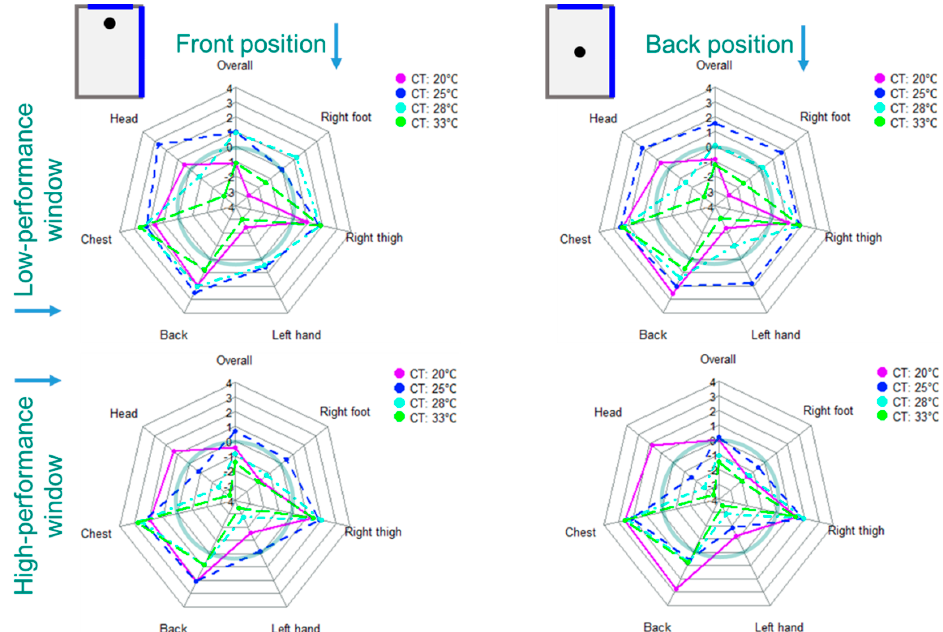
Figure 18. Overall and local thermal comfort at selected body limbs in the corner room influenced by ceiling temperatures, quality of facades, and the position of the manikin. Nine-point thermal comfort scale: “ − 4 = very uncomfortable”, “ − 2 = uncomfortable”, “0 − = just uncomfortable”, “0 + = just comfortable”, “+2 = comfortable”, and “+4 = very comfortable”.